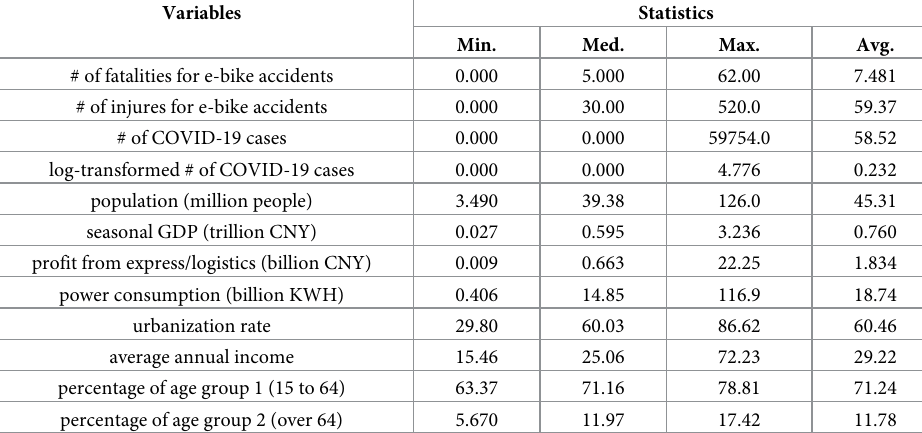
Table 1. Variables and statistics.